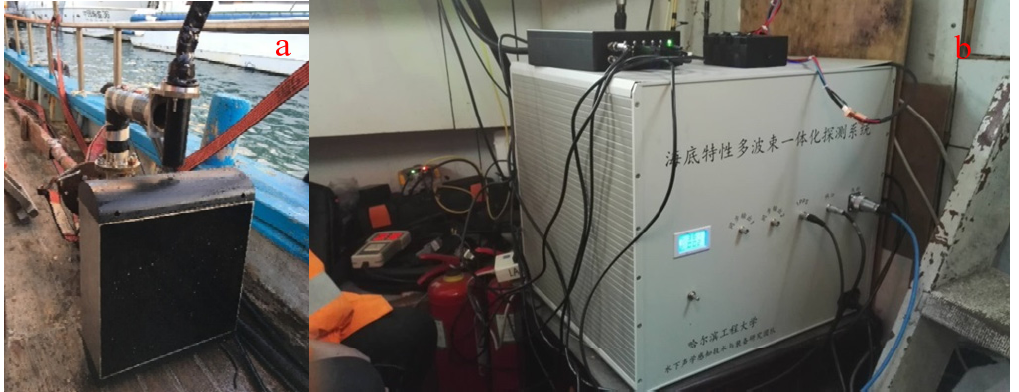
Figure 3. Portable integrated seabed detection system. ( a ) Integrated detection sonar array; ( b ) transmitter.